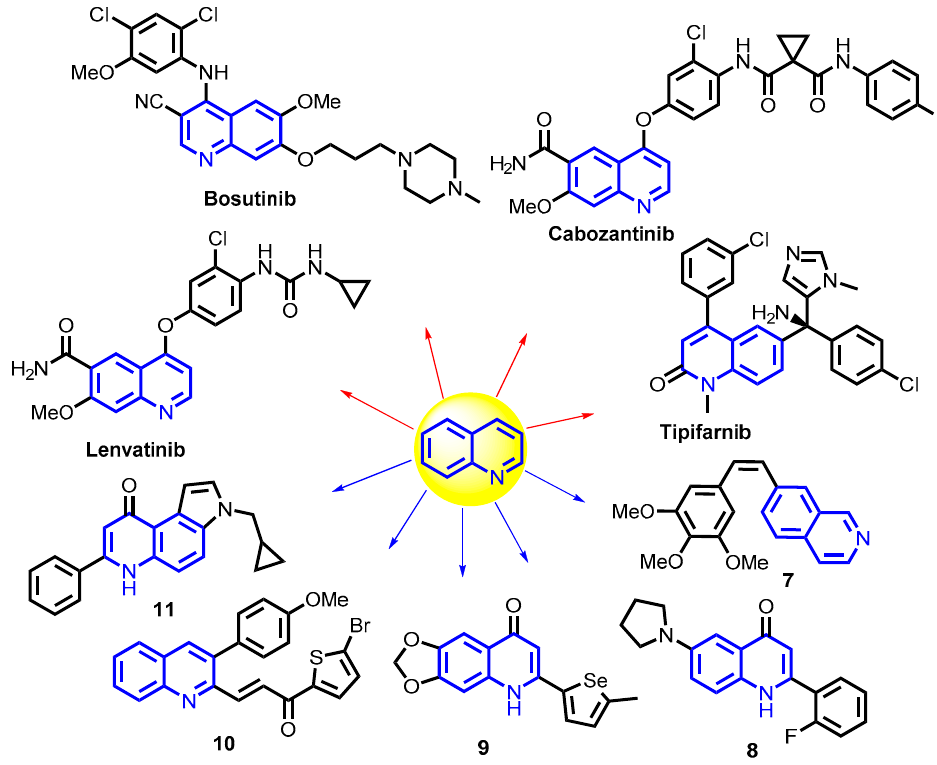
Figure 3. Examples of quinoline containing antimitotic agents and tubulin polymerization inhibitors& quinoline containing anticancer drugs.